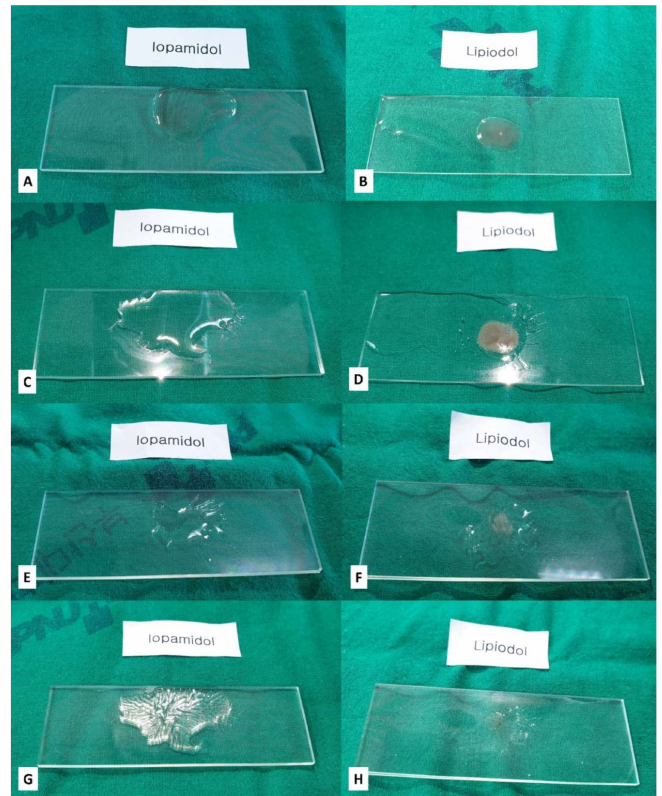
Figure 3. Image shows the conglomeration of chyle by iopamidol and lipiodol drops in vitro (on the slide) every 5, 10, and 30 min. ( A , B ) immediately and ( C , D ) 5, ( E , F ) 10, and ( G , H ) 30 min after dropping and mixing the samples on the slide. (Group B #1